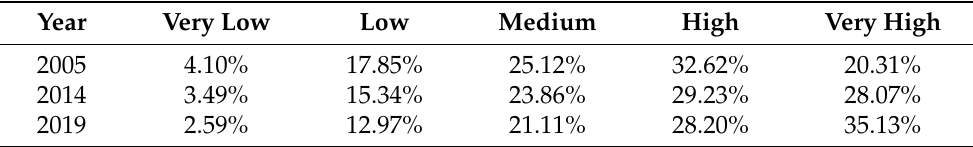
Table A6. Changes in the percentage of the different vulnerability levels from 2005–2019